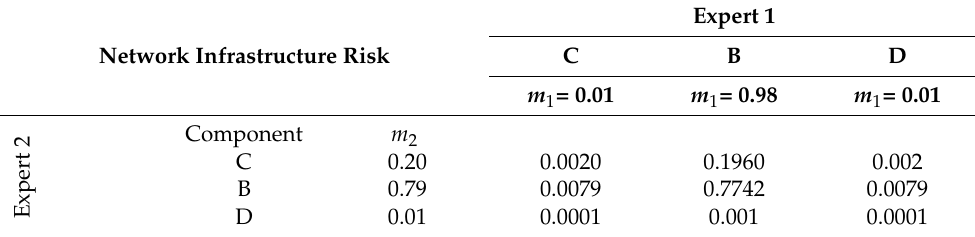
Table 7. Dempster combination of Expert 1 and Expert 2 for network infrastructure